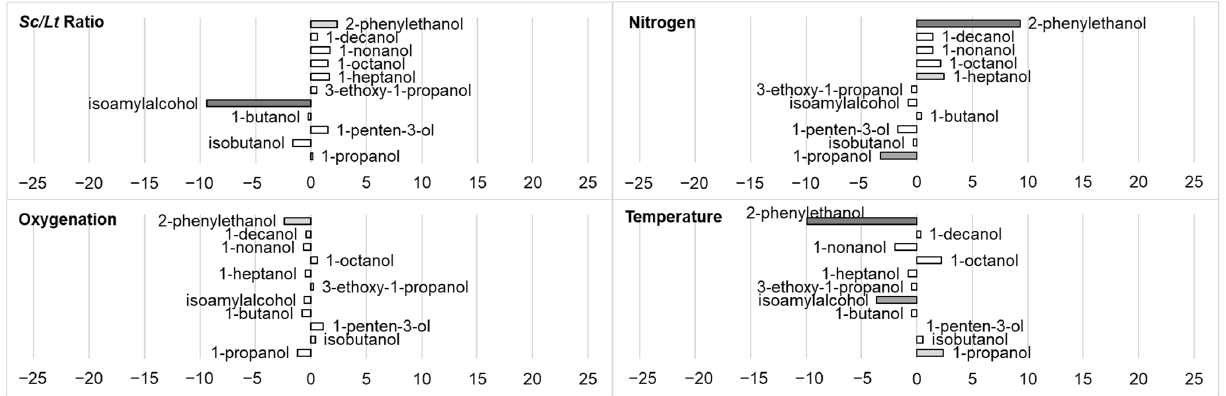
Figure 4. Impact (standardized effects) of fermentation parameters ( Sc / Lt ratio, nitrogen, oxygenation, temperature) on the production of different volatile alcohols. Data are identified as statistically almost significant (0.05 < p -value < 0.1, light grey), significant ( p -value < 0.05, grey), or very significant ( p -value < 0.01, dark